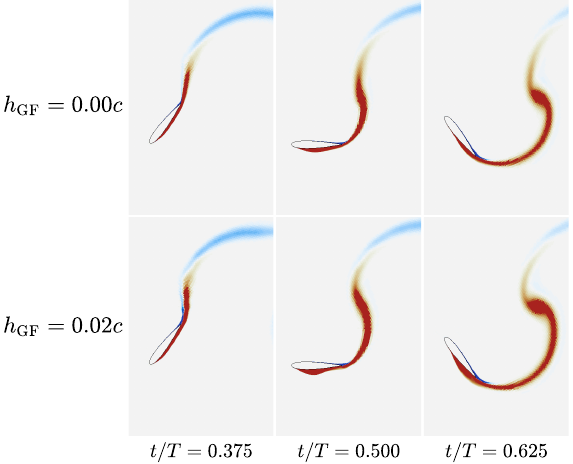
Figure 11. Normalized z-vorticity field during reversal for two double GF heights at f ∗ = 0.16. Positive vorticity in red, negative vorticity in blue.